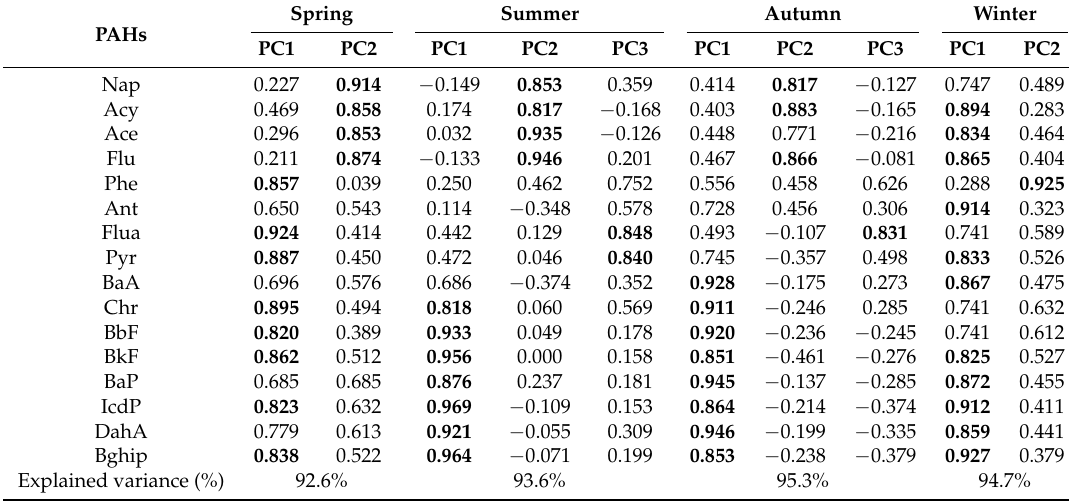
Table 2. Factor patterns of principle components (PC) 1 and 2, for individual PAHs (gas plus particle phase) in air from Chengdu, China.